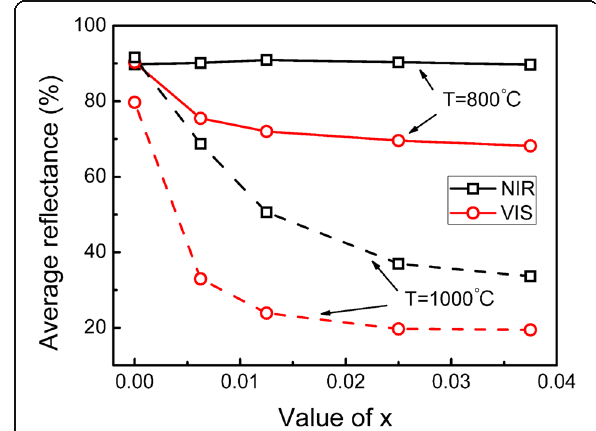
Fig. 6 Effect of Cr concentration on the average spectral reflectivity of Ti 1 − x Cr x O 2 samples (VIS, 0.4 – 0.8 μ m; NIR, 0.8 – 2.5 μ